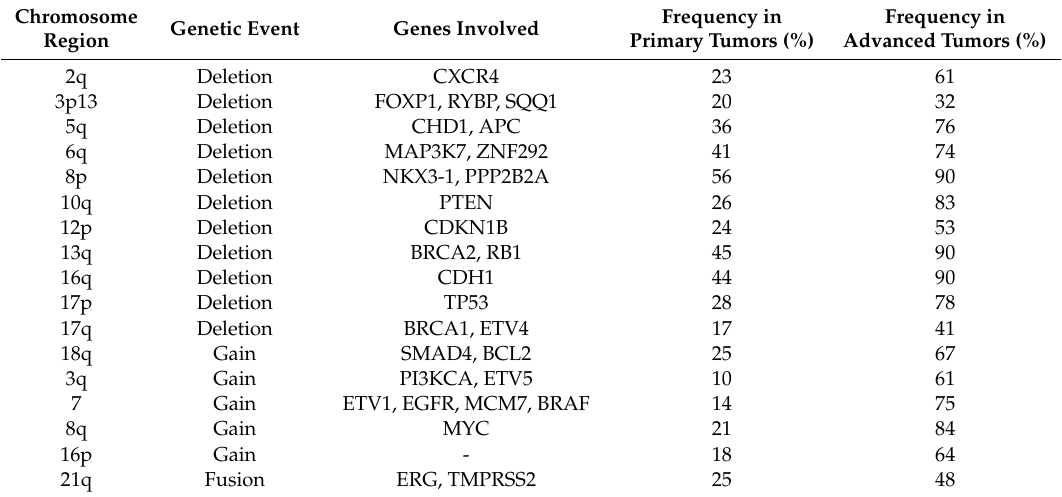
Table 1. Recurrent copy number alterations observed in prostate cancers (data reported in Refs. [78,79]). Chromosome Genetic Event Genes Involved Region